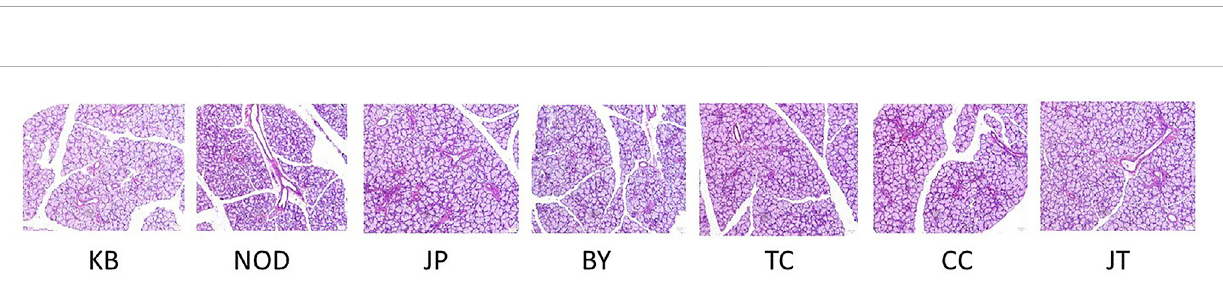
control; NOD model; tangeretin; chrysin; sinensetin; 5-demethylnobiletin; extract administration.